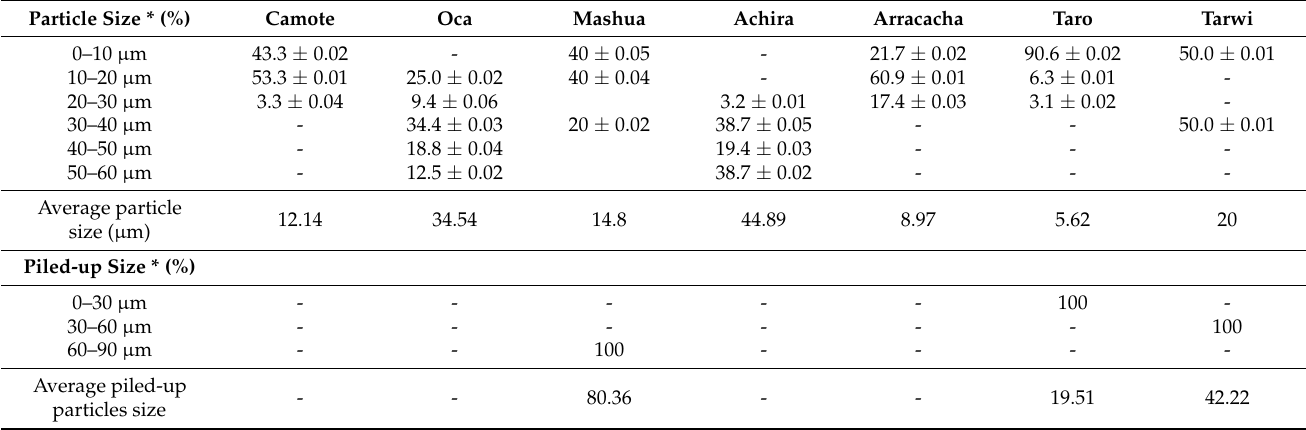
Table 4. The particle size distribution of andean crops